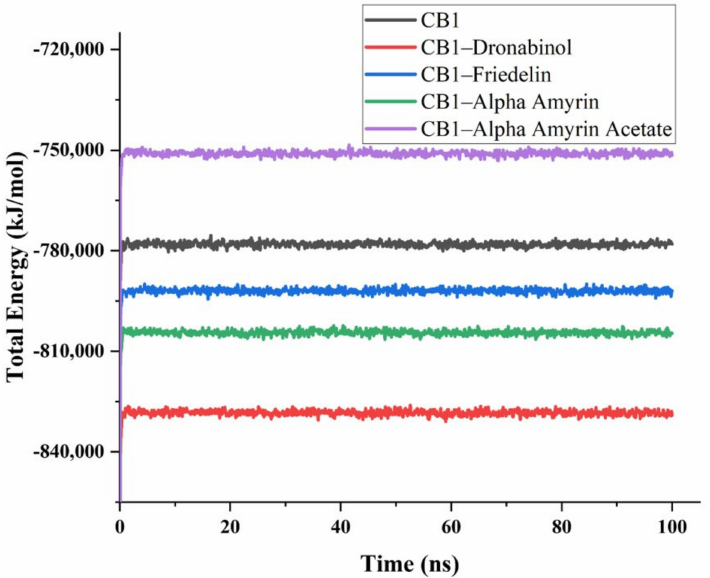
Figure 2. Total potential energies (kJ/mol) of the CB1 protein and the CB1–ligand complexes as a function of